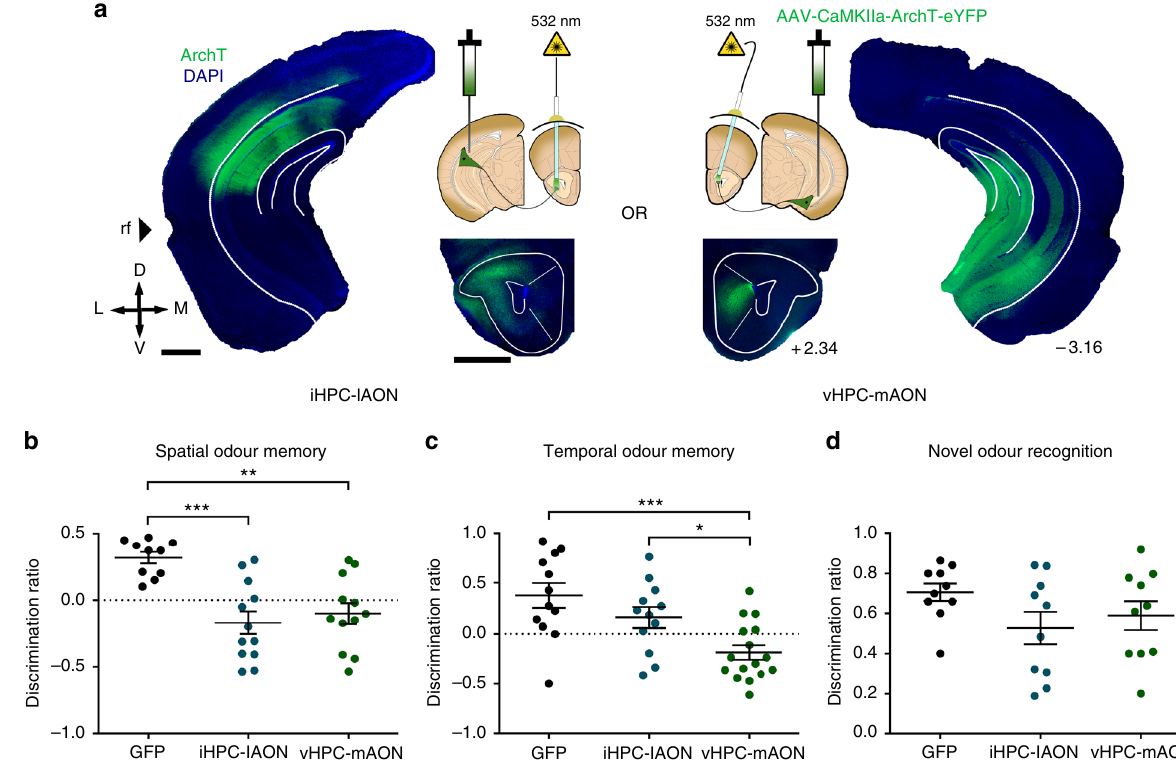
Fig. 2 Spatial and temporal information is transmitted along separate HPC-AON circuit elements. a Diagram depicting location of ArchT infusions within the HPC and optic fi bre implantations above the AON in both experimental groups. iHPC terminals are predominantly found in the lAON (left) whereas vHPC fi bres preferentially innervate the mAON (right). b Inhibition of both iHPC-lAON and vHPC-mAON pathways impaired spatial odour memory (GFP: n = 10; iHPC-lAON: n = 12; vHPC-mAON: n = 12; one-way ANOVA, F (2,31) = 11.65, *** P < 0.0005). c Inhibition of the vHPC-mAON, but not iHPC- lAON pathway impaired memory for the temporal order of a sequence of odours (GFP: n = 12; iHPC-lAON: n = 12; vHPC-mAON: n = 16; one-way ANOVA,